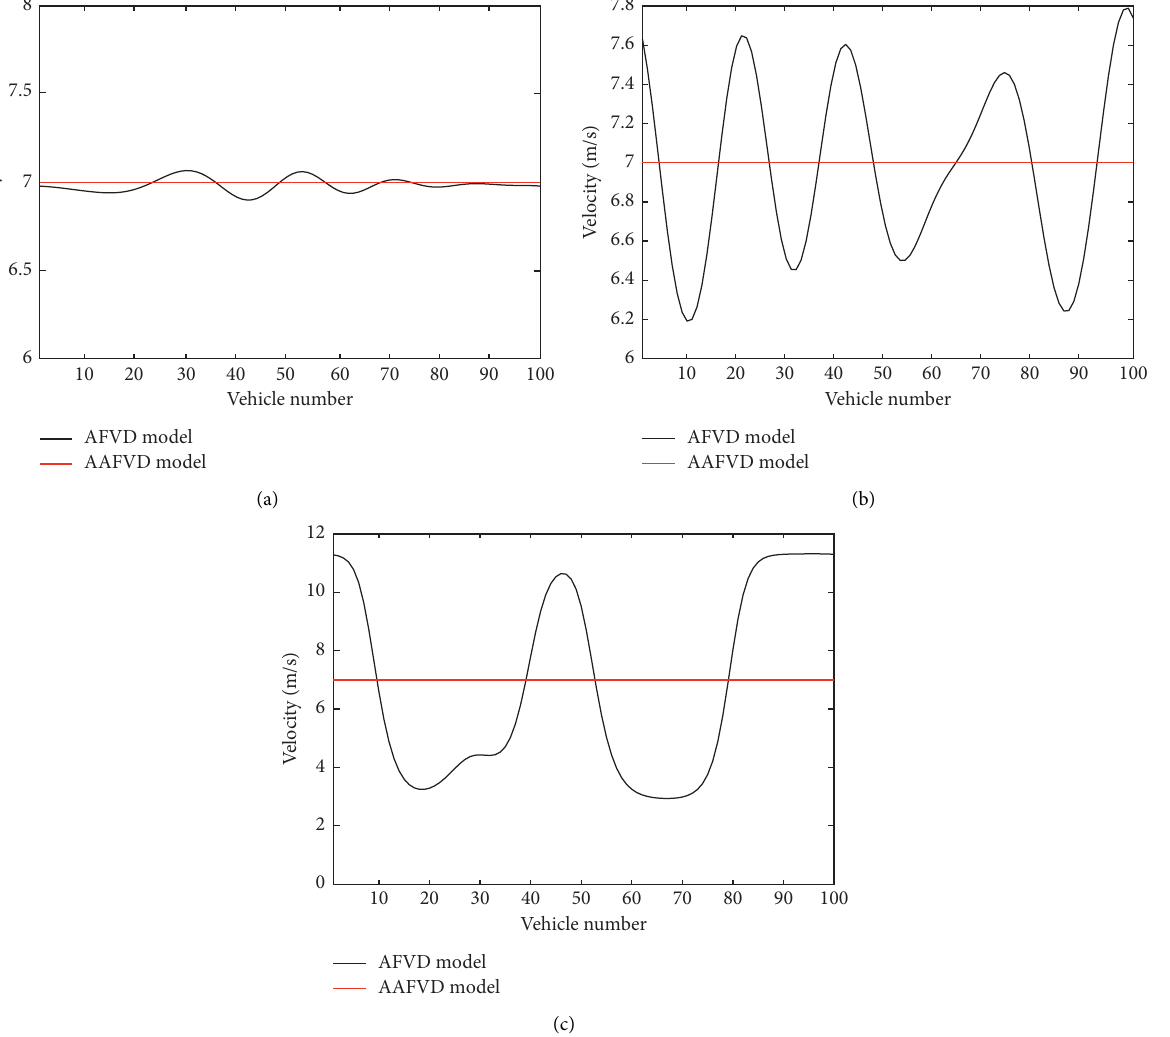
Figure 11: Snapshots of 100 vehicles’ velocity simulated by the AFVD model ( T � 0, p � 0) and the AAFVD model ( T � 0.1, p � 0 . 3) at (a) 300s, (b) 800s, and (c) 5000s.